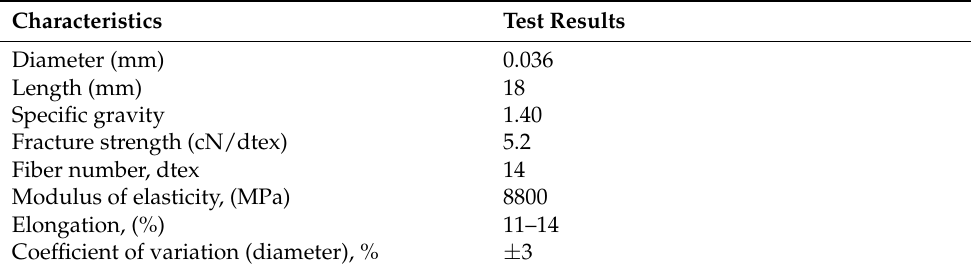
Table 4. Technical parameters of polyformaldehyde